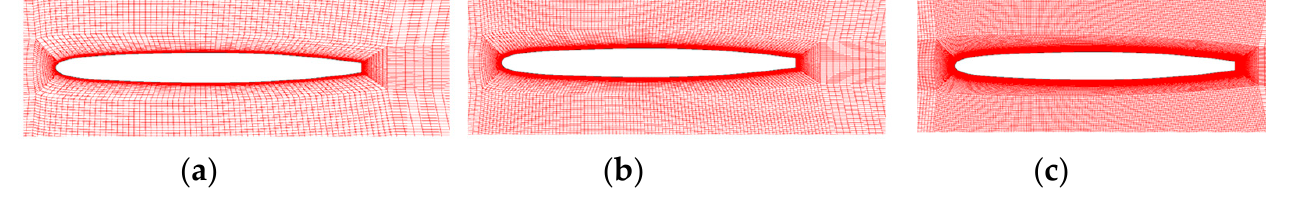
Figure 5. Three grid schemes: ( a ) G1, ( b ) G2, ( c ) G3. Table 2. Evaluation results of discretization error in GCI check.